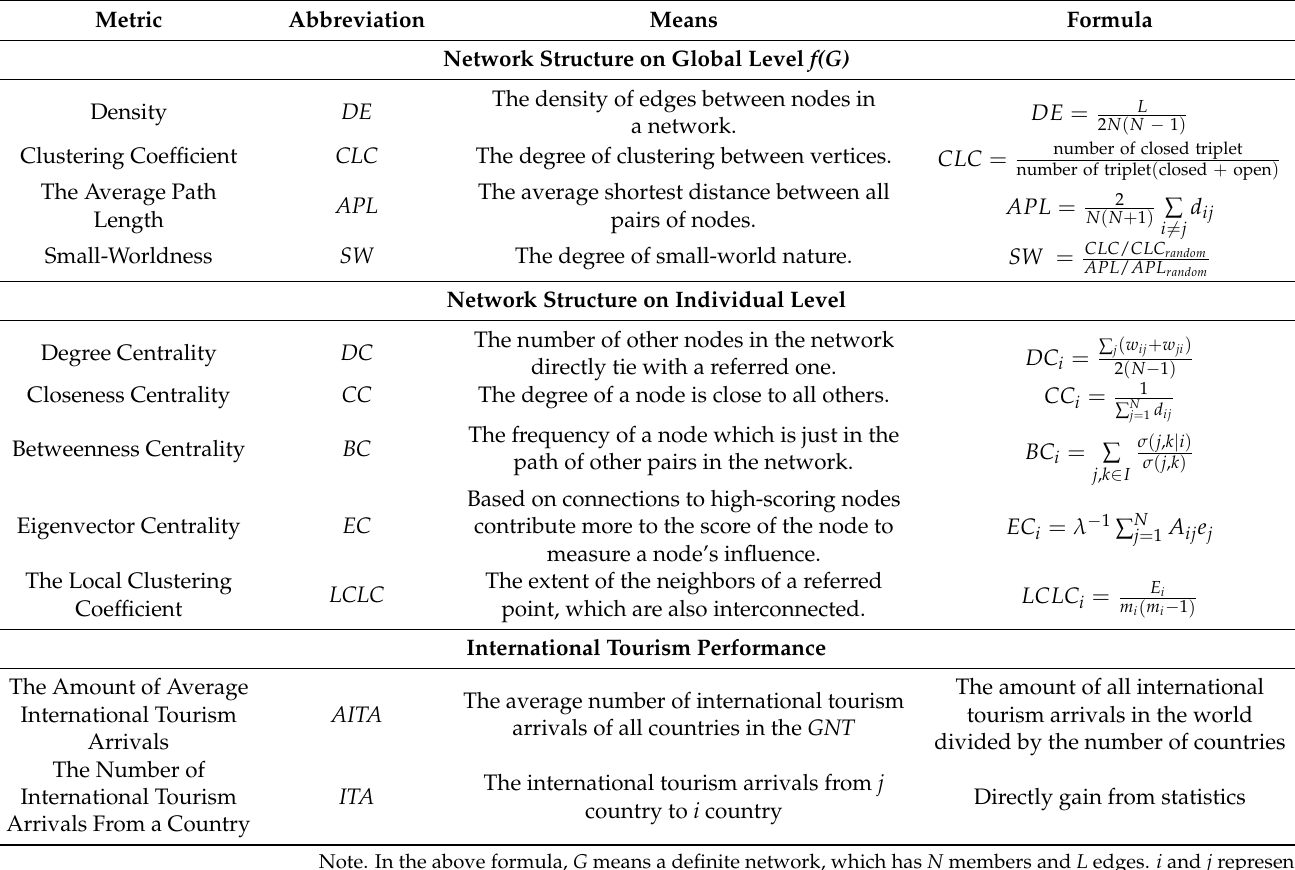
Table 1. The measurements of network structures and international tourism